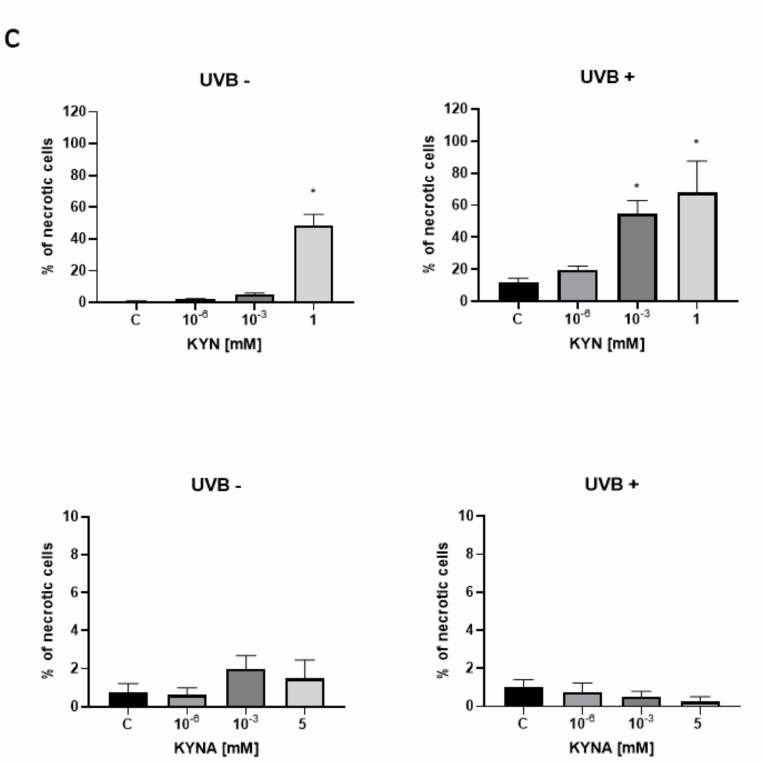
Figure 6. The effect of UVB on cell death in melanoma SK-MEL-3 cells exposed to KYN ( a ) and KYNA ( b ). Melanoma SK-MEL-3 cells were exposed to UVB (20 mJ/cm 2 ; UVB+) and then to culture medium (control, C) or serial dilutions of KYN (10 − 6 , 10 − 3 , and 1 mM) and KYNA (10 − 6 , 10 − 3 , and 5 mM) for 24 h. Similarly, the biological activity of KYN and KYNA was studied in melanoma cells under standard conditions (UVB − ). The effect of UVB and tryptophan metabolites on the induction of cell death was assessed by co-staining with Hoechst 33342 (blue) and propidium iodide (red). Apoptotic fraction represented cells with fragmented nuclei stained in intense blue color. Nuclei of necrotic cells were stained with pink color (indicated by white arrows). Magnification 10 × . ( c ) Quantitative analysis of necrotic cells. The number of necrotic cells per 100 SK-MEL-3 cells was assessed in at least three fields of view. Values significant (*) in comparison with the control with p < 0.05 (one-way ANOVA with Tukey’s post hoc